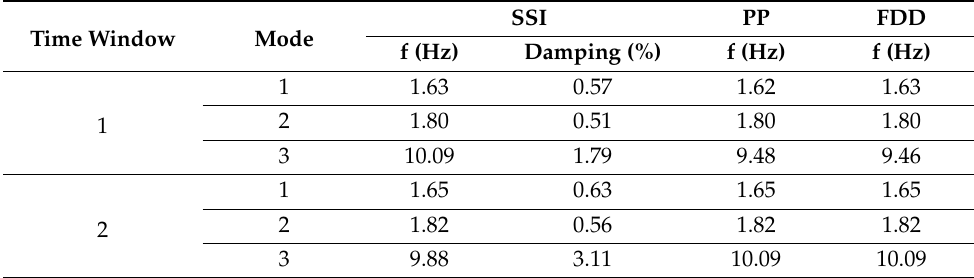
Table 2. Modal identification results for the minaret estimated using parametric SSI and non- parametric PP and FDD identification